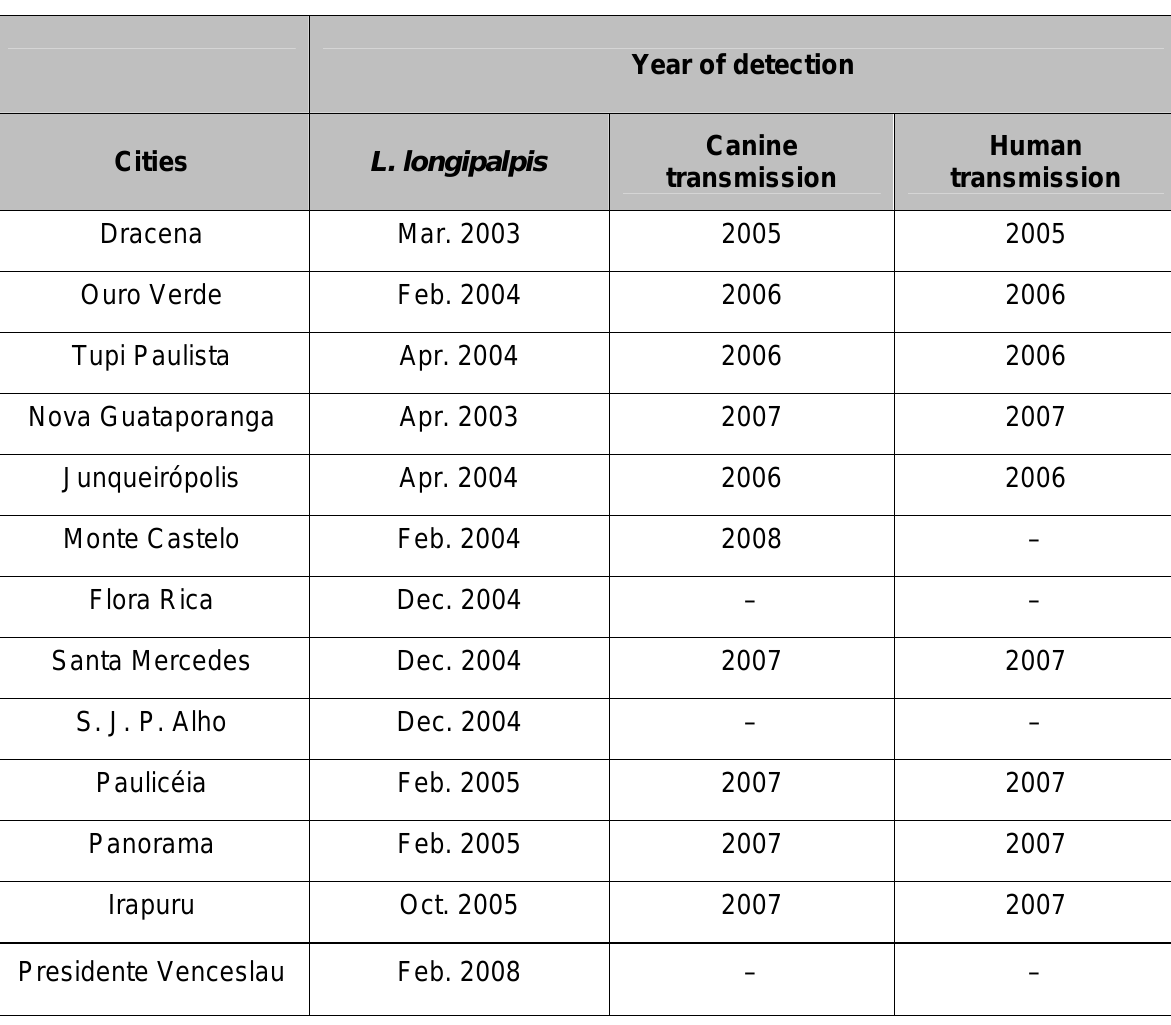
Table 2. Years of detection of L. longipalpis and canine and human AVL transmission in 12 cities belonging to Dracena microregion, Alta Paulista (SP), as well as neighboring